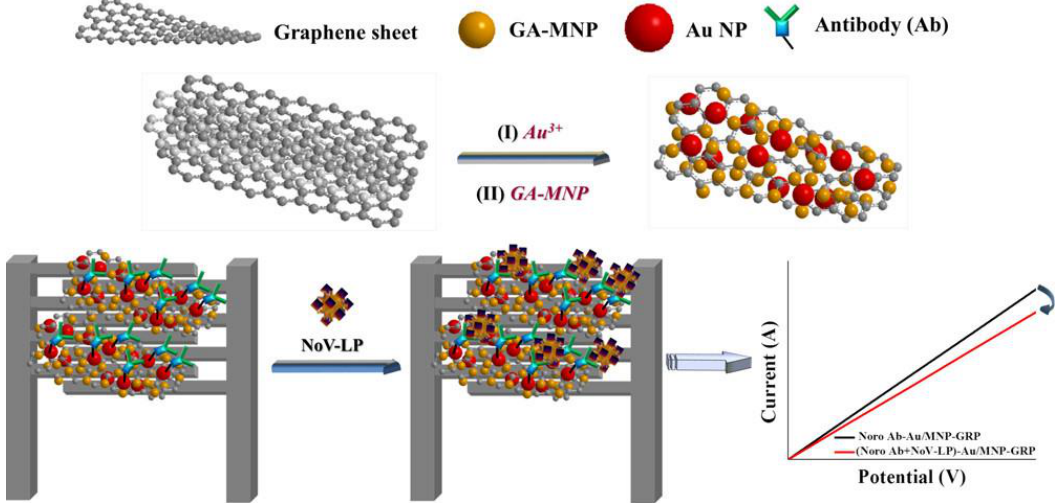
Figure 3. Schematic diagram of electrochemical sensors for a norovirus-like particle. Adapted with permission from ref. [20]. Copyright © 2017, American Chemical Society. permission from ref. [20]. Copyright © 2017, American Chemical